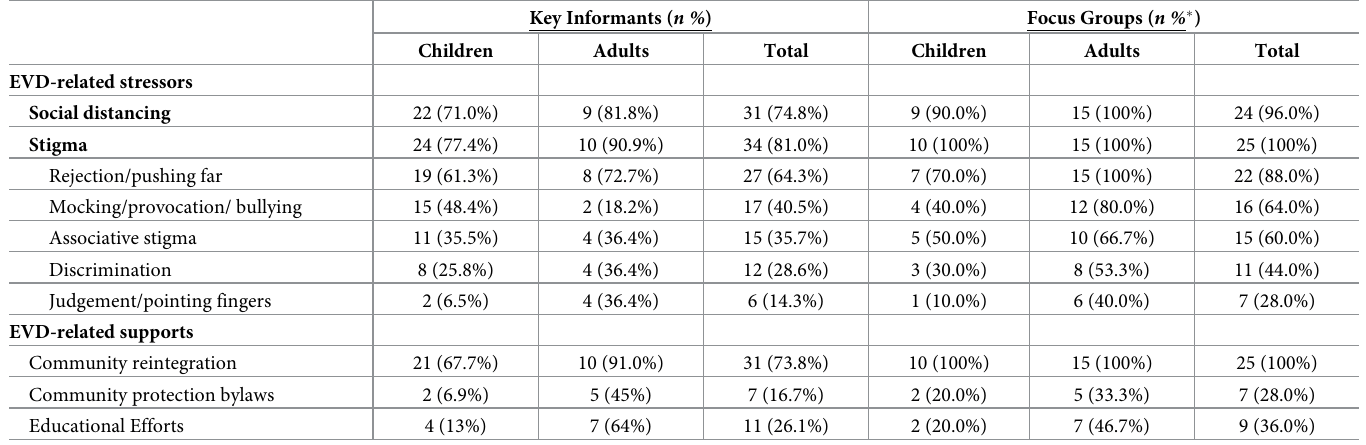
Table 2. EVD-related stressors and